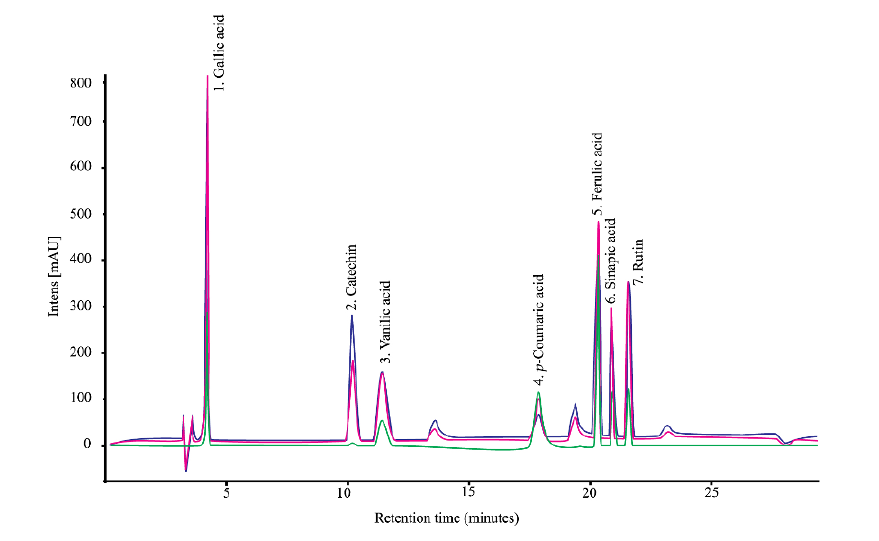
Figure 6. HPLC-UV-VIS DAD chromatogram of mixture of polyphenols standards at 210 nm, Supelcosil LC-18-DB column, 30°C, gradient elution: solvent A (95% (v/v) acetonitrile acidified with 0.35 mL TFAA) and solvent B (50% (v/v) aqueous acetonitrile acidified with 0.25 mL TFAA), injection volume 10 µL, flow rate of 1 mL min -1